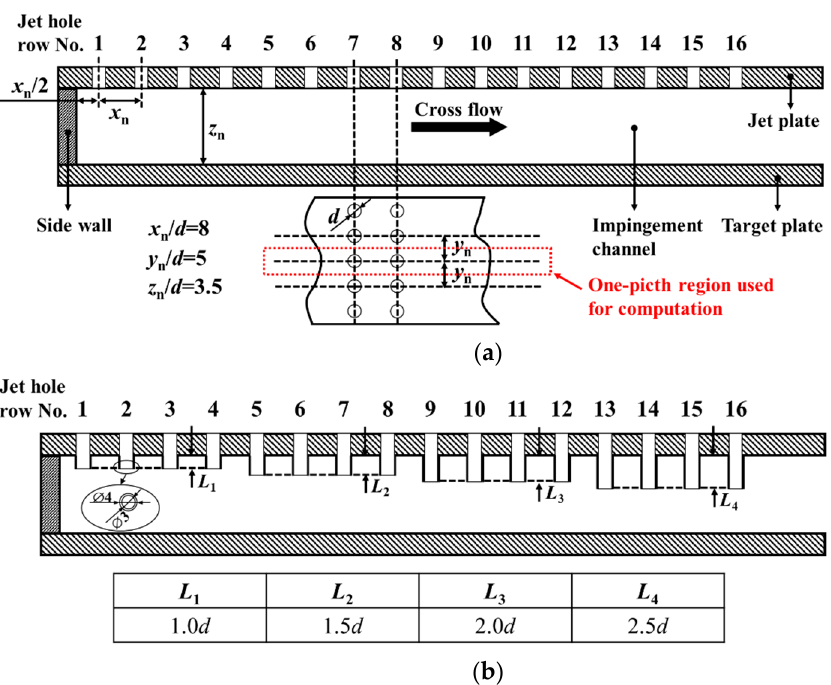
Figure 1. Geometrical configurations of baseline and variable extended jet hole impingement cooling systems: ( a ) baseline impingement configuration; ( b ) variable extended jet hole design.